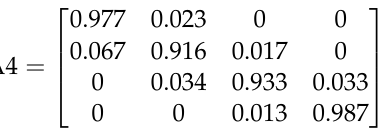
Table 2. Revenue from different maintenance decisions.